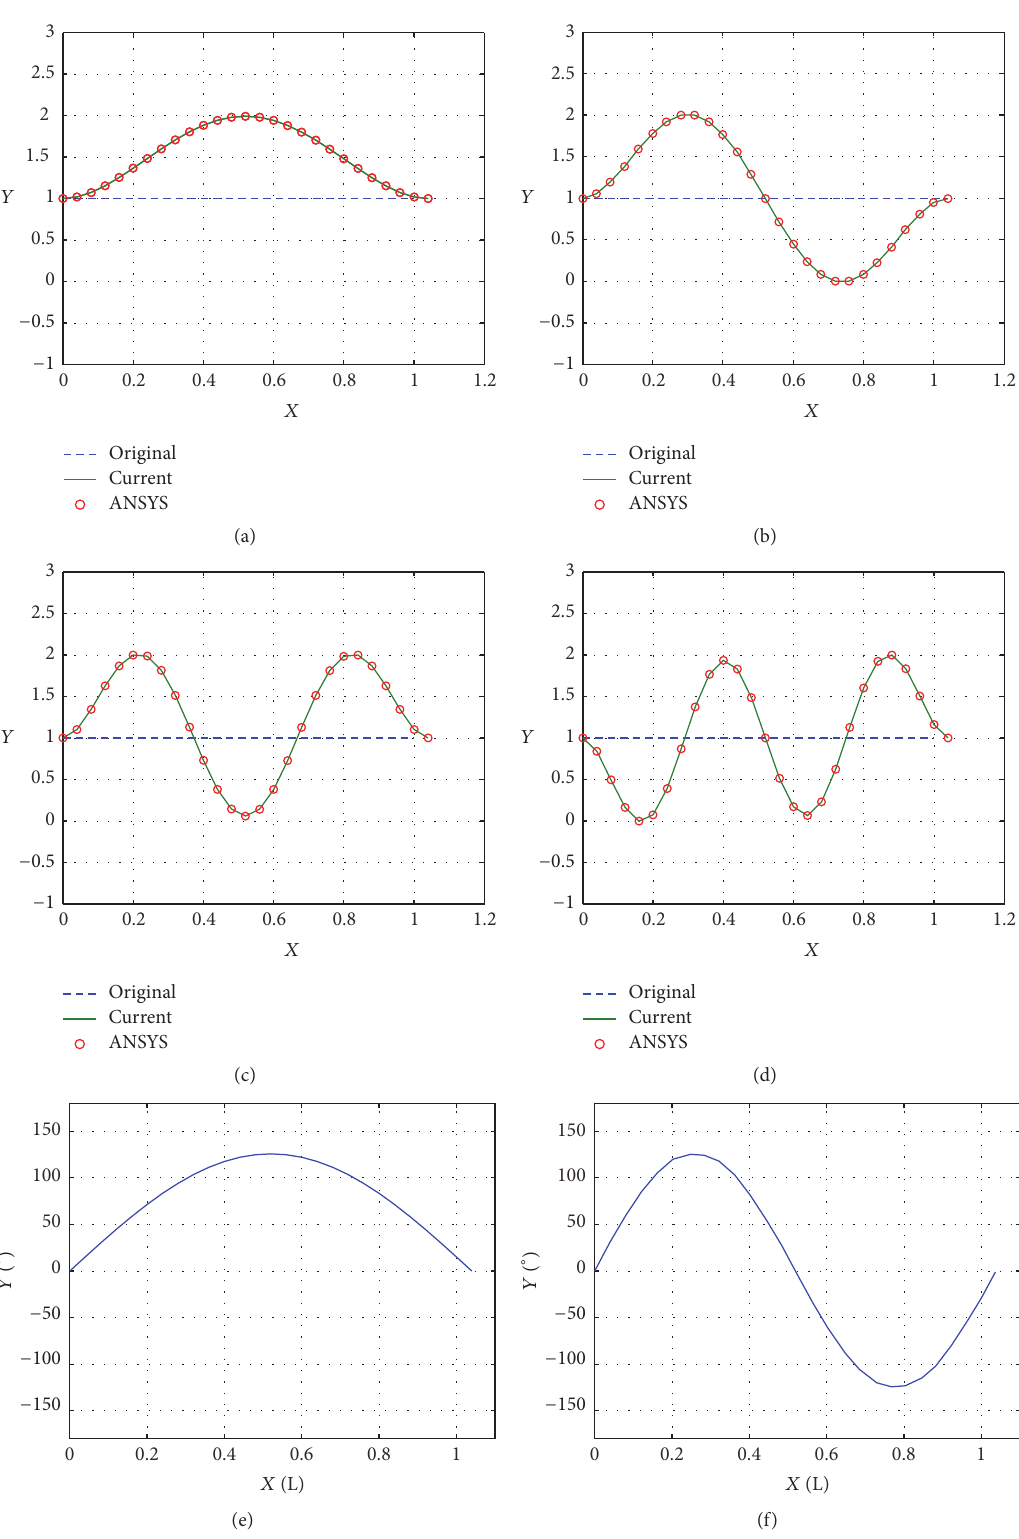
Figure 3: The modes of coupled beams with C-C: (a) the first mode, (b) the second mode, (c) the third mode, (d) the fourth mode, (e) first rotational vibration, (f) second rotational